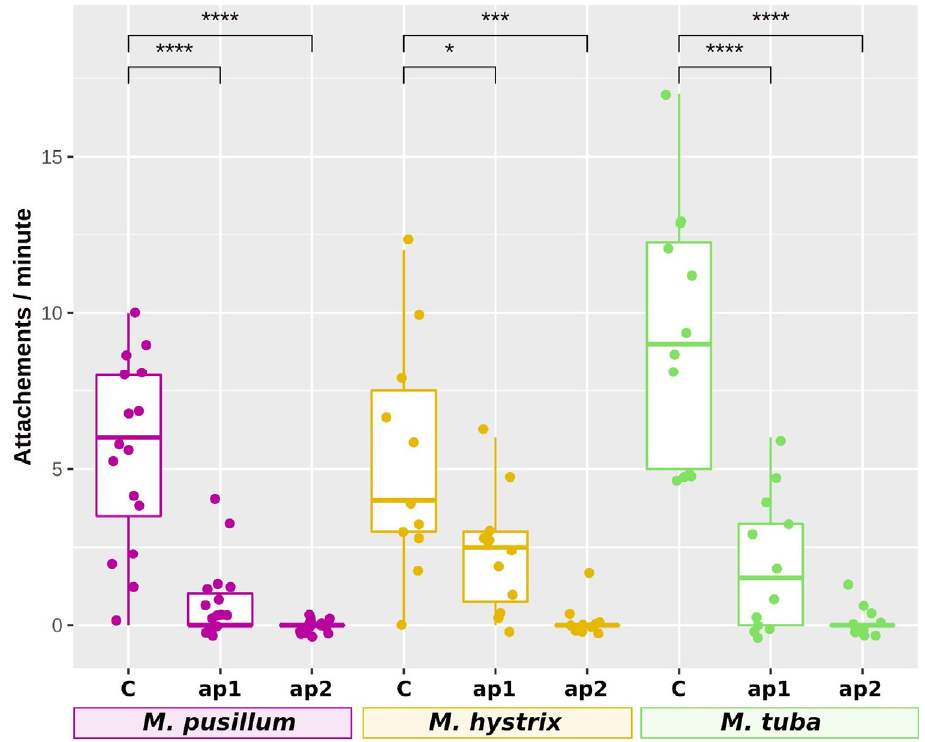
Figure 6. Adhesion assay of RNAi-treated animals. Attachments per minute as observed by different investigators of control animals, ap1 RNAi-, and ap2 RNAi-treated animals. Marine species outlined in pink, brackish species outlined in yellow, freshwater species outlined in green. The significance of a pairwise t.test is shown above the box plots (* = p -value < 0.5; *** = p -value < 0.001; **** = p -value < 0.0001). C: control, animals were not treated with RNAi; ap1 : RNAi against ap1-like ; ap2 : RNAi against ap2-like transcript.